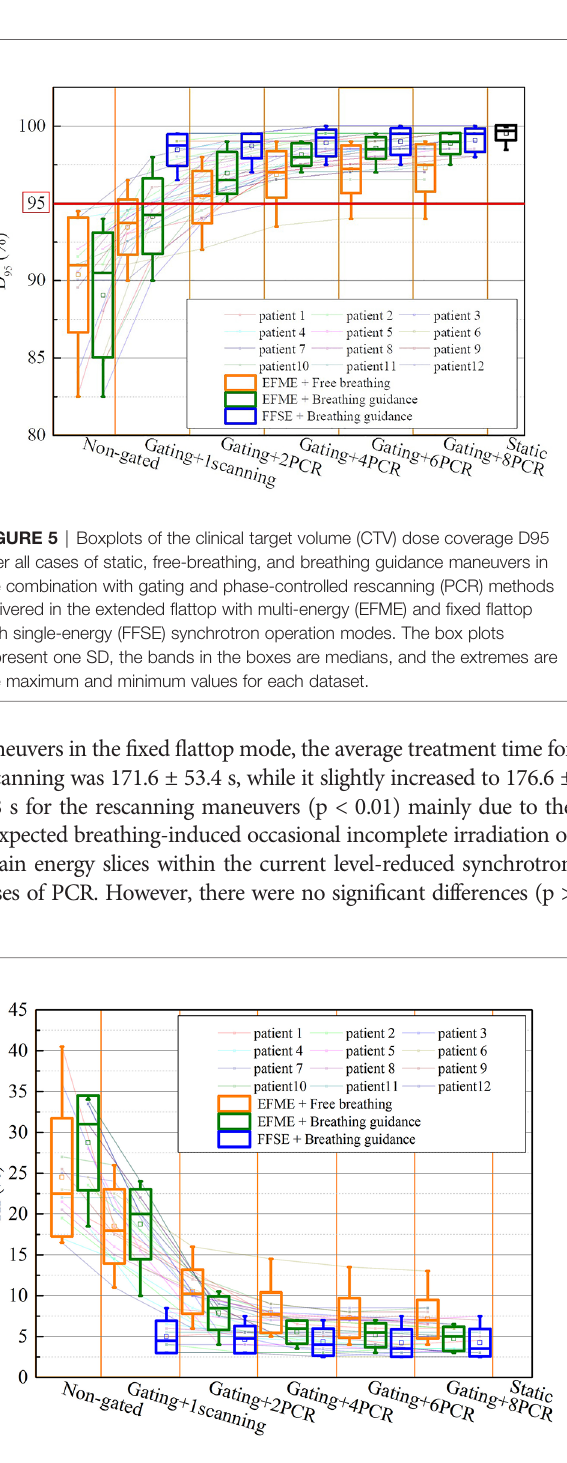
FIGURE 6 | Values of the dose homogeneity index (HI) over all cases of static, free-breathing, and breathing guidance maneuvers in the combination with gating and phase-controlled rescanning (PCR) methods delivered in the extended fl attop with multi-energy (EFME) and fi xed fl attop with single-energy (FFSE) synchrotron operation modes. The box plots represent one SD, the bands in the boxes are medians, and the extremes are the maximum and minimum values for each